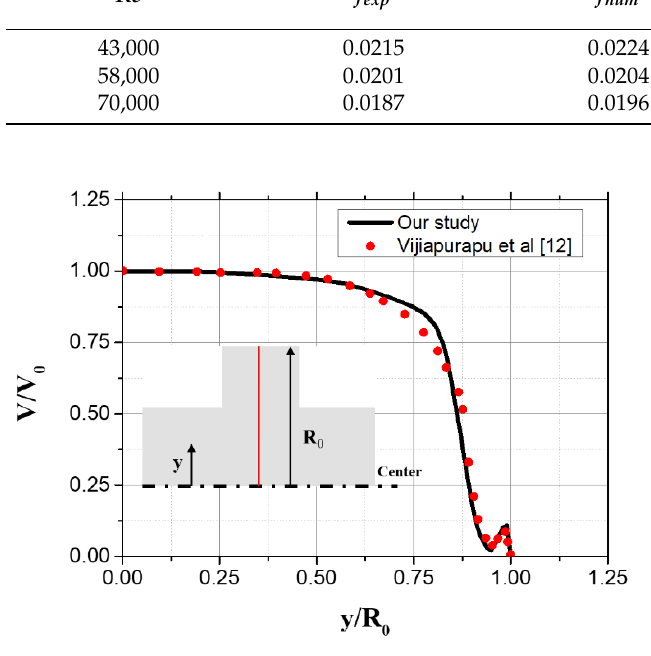
Figure 6. Comparing the velocity profile at the center of the groove . Table 3. Comparison of Experimental results and Numerical results based on friction factor.